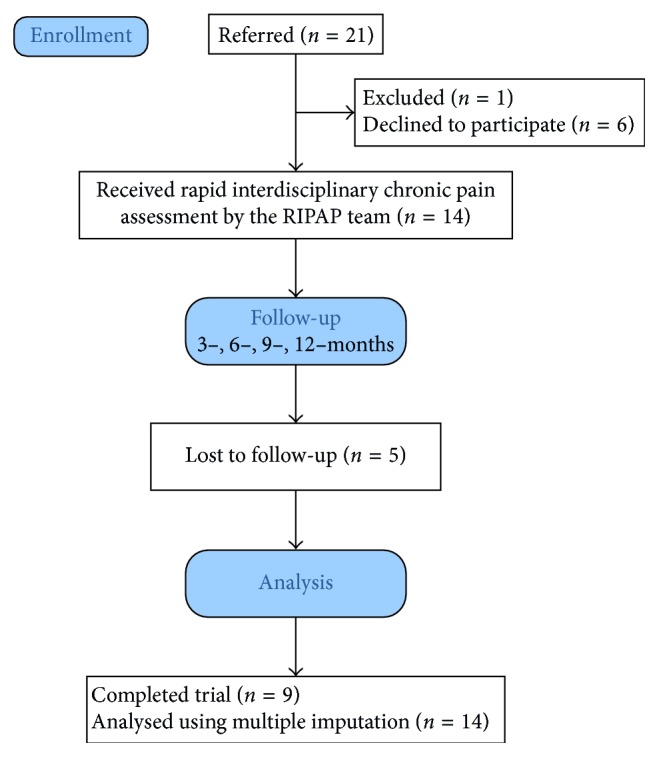
Study flow diagram.